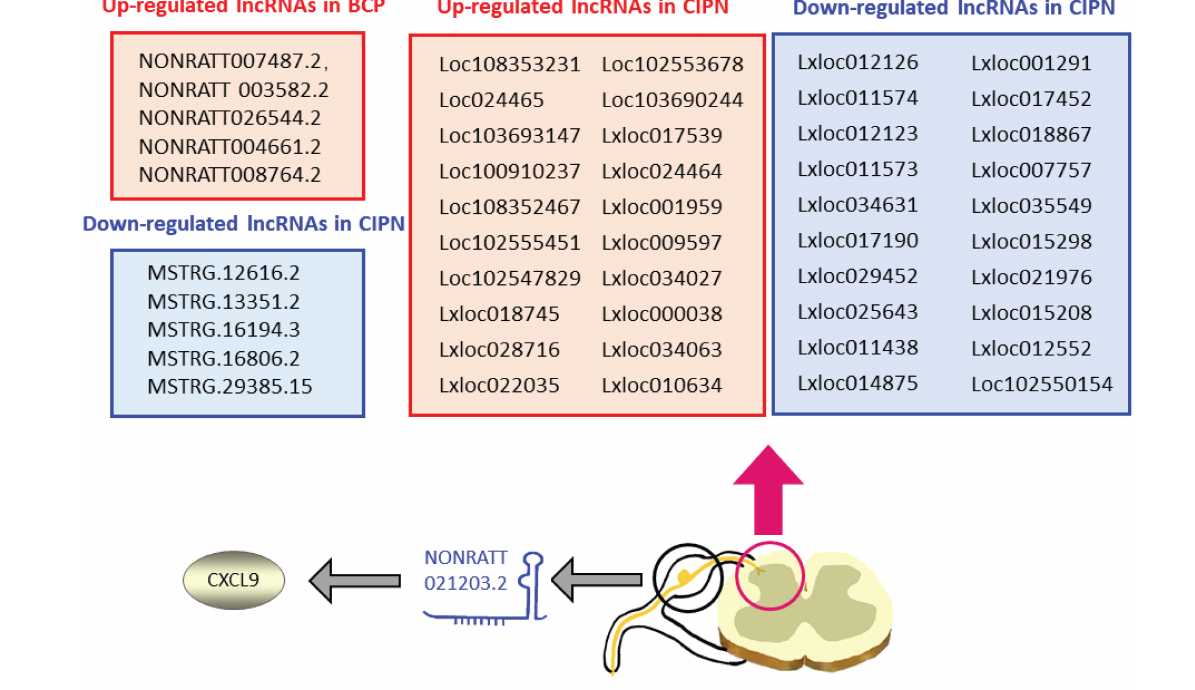
evidence has shown that lncRNAs are related to the development of CCRP ( Figure 3